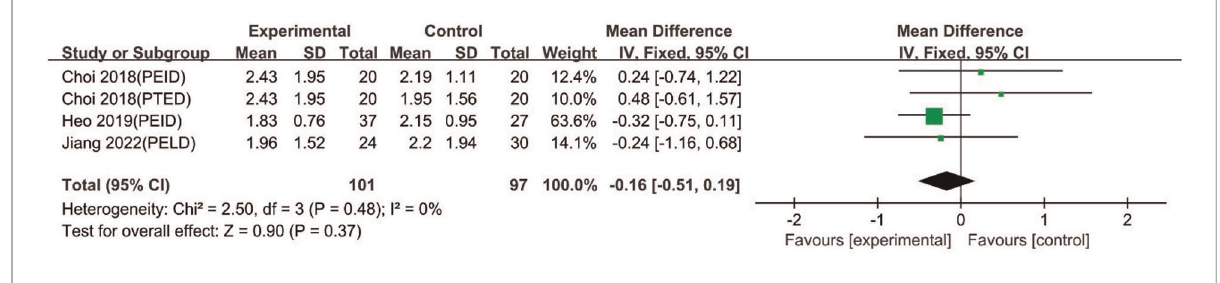
FIGURE 14 Forrest plot of vas leg pain 1-day UBE vs PELD.